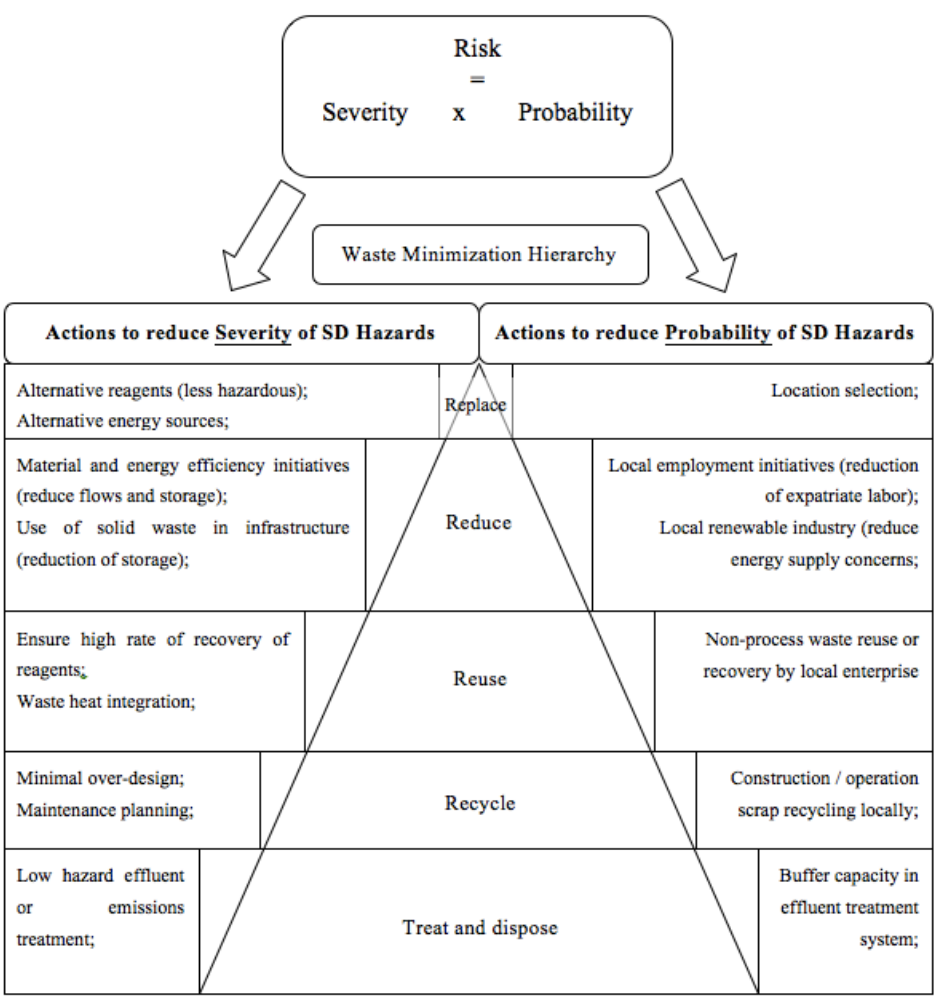
Figure 1. Waste minimization hierarchy and its relationship to reducing the severity and probability of